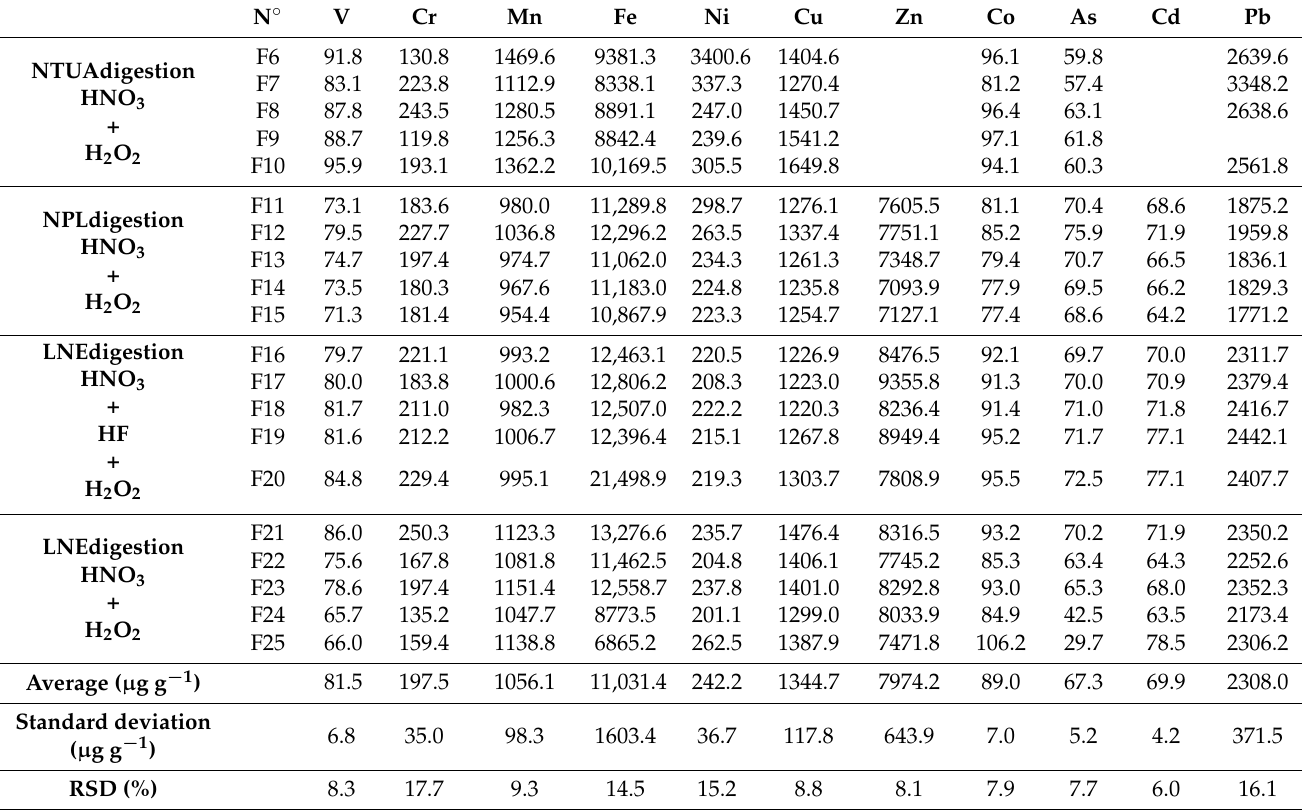
Table A3 summarizes the mass concentration of each metal obtained by all participants for the PM 2.5 filters. The RSD values are below 20%. Table A3. Metals concentrations (in µ g · g − 1 of deposited materials) and % relative standard deviation between all partici- pants for PM 2.5